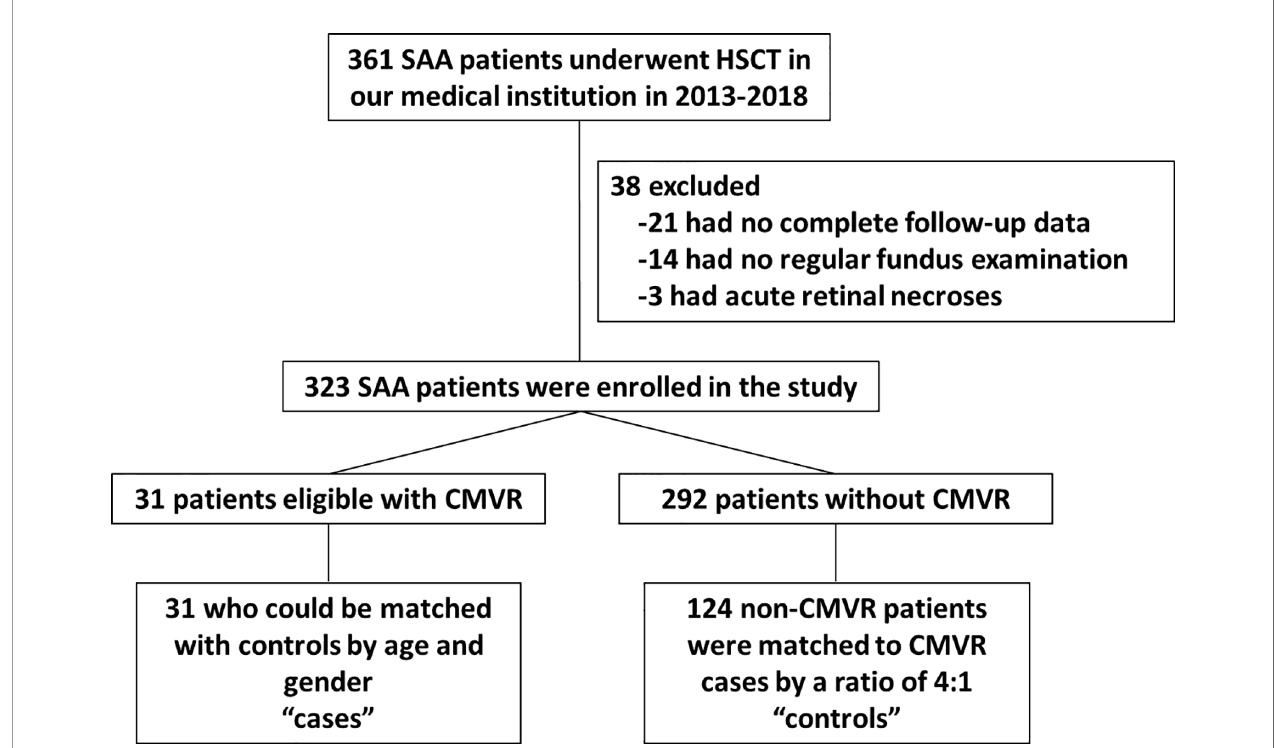
FIGURE 1 | Flow chart of SAA patients selected for the study. SAA, severe aplastic anemia; HSCT, hematopoietic stem cell transplantation; CMVR, cytomegalovirus retinitis.